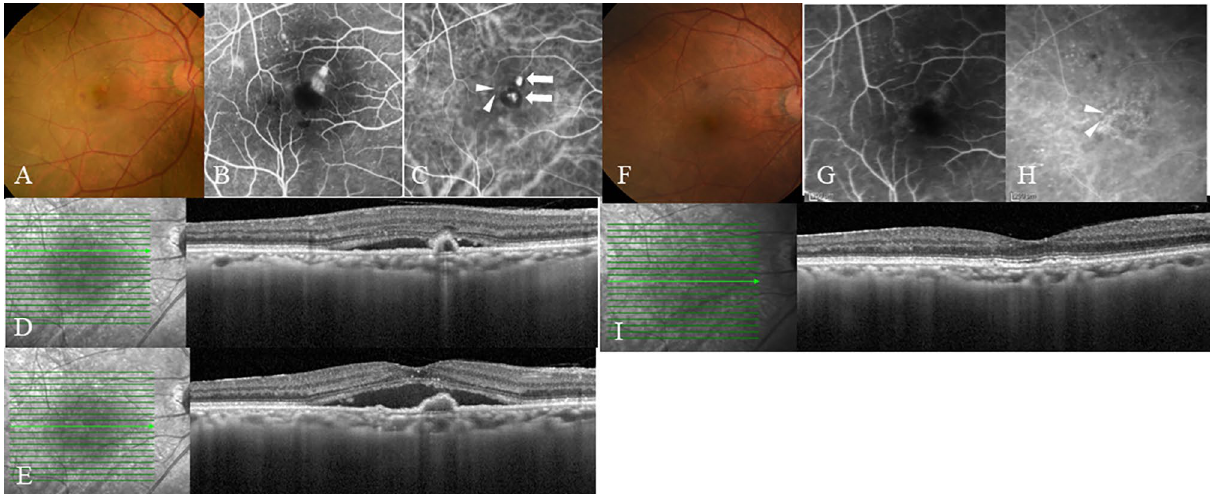
Figure 4. The case of an 86-year-old man who presented with reduced visual acuity in his right eye. ( A ) A color fundus photograph shows reddish-orange polypoidal lesions, including his fovea, submacular hemorrhage, and a large area of subretinal fluid (SRF). ( B ) Fluorescein angiography (FA) demonstrates occult leakage. ( C ) Indocyanine green angiography (ICGA) shows two polypoidal lesions (white arrows) and an abnormal vascular network (arrow heads). ( D , E ) An optical coherence tomography (OCT) images obtained at baseline show SRF with polypoidal lesions. ( D through the superior polypoidal lesion, E through the inferior polypoidal lesion involving the fovea) The visual acuity (VA) was 0.39 logarithm of the minimum angle of resolution (logMAR) in the right eye, and the patient was diagnosed with PCV. The patient received IVBr injections during the loading phase and during the maintenance phase, he was treated every 3 months IVBr injections. The exudative changes did not recur for 1 year. Twelve months after the first injection, the VA improved to 0.045 logMAR. ( F ) A color fundus photograph shows no reddish-orange lesion or hemorrhage at the macula. ( G ) FA shows staining with no leakage. ( H ) ICGA shows complete polyp regression, although an abnormal vascular network (arrow heads) remained. ( I ) OCT shows no polypoidal lesion or SRF. Irregular retinal pigment epithelium elevation was observed where the abnormal vascular network was